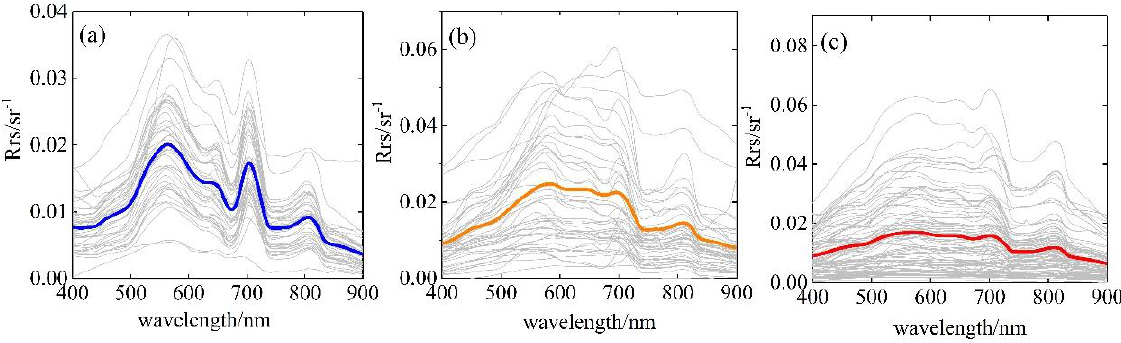
Figure 2. Remote sensing reflectance of BOW and GW: ( a ) GW; ( b ) MBOW; and ( c ) SBOW. The blue, orange, and red curves represent the average reflectance values of GW, MBOW, and SBOW between 400 and 900 nm, respectively.